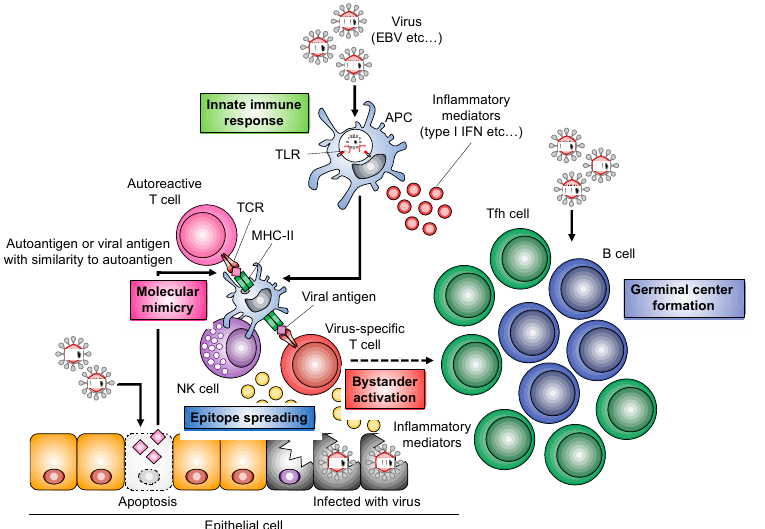
Figure 2. Relationship between virus infection and the pathogenesis of SS. Molecular mimicry, epitope spreading, and bystander activation are among the mechanisms associated with the onset or progress of SS in the target organ or the peripheral immune system.